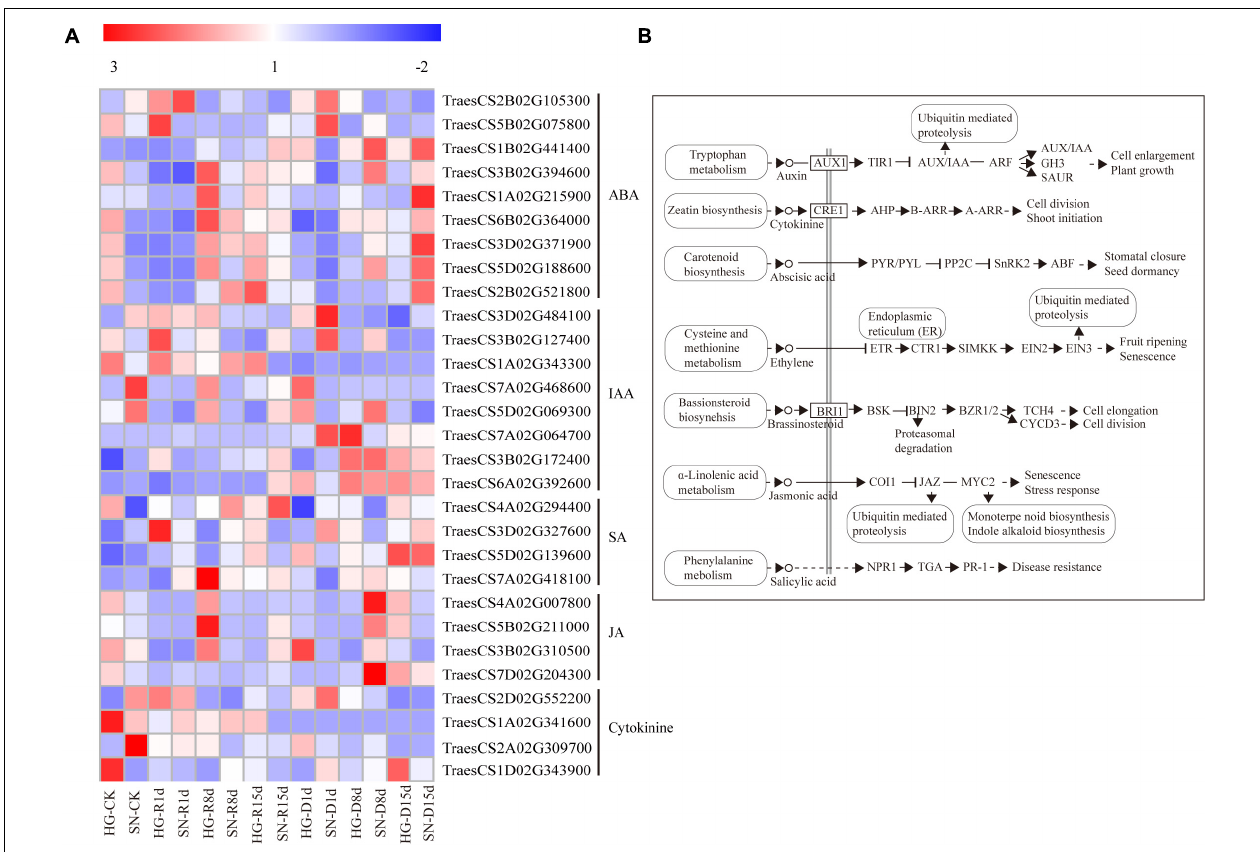
FIGURE 7 | Expression profiles of DEGs involved in plant hormone pathways. The expression profiles of transcripts (A) involved in hormone signal transduction pathways (B) were generated using their FPKM values.